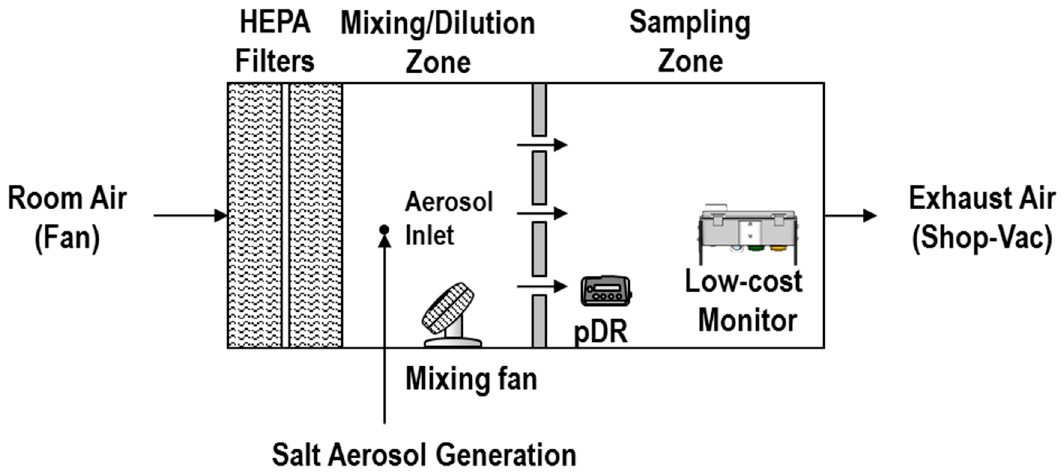
Figure 1. Experimental set up used to select the Sharp particulate matter (PM) sensors.